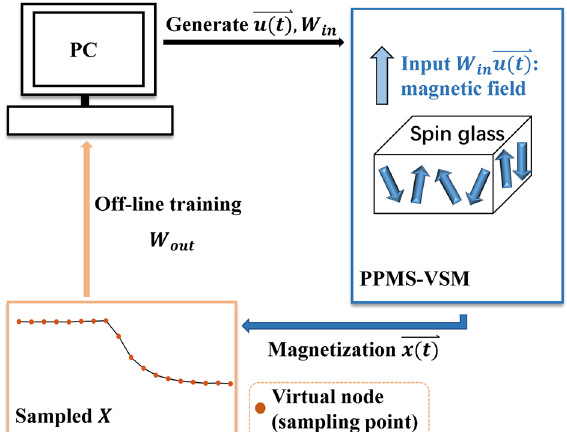
Figure 3. Schematic of reservoir computing experiment implementation on spin cluster glass